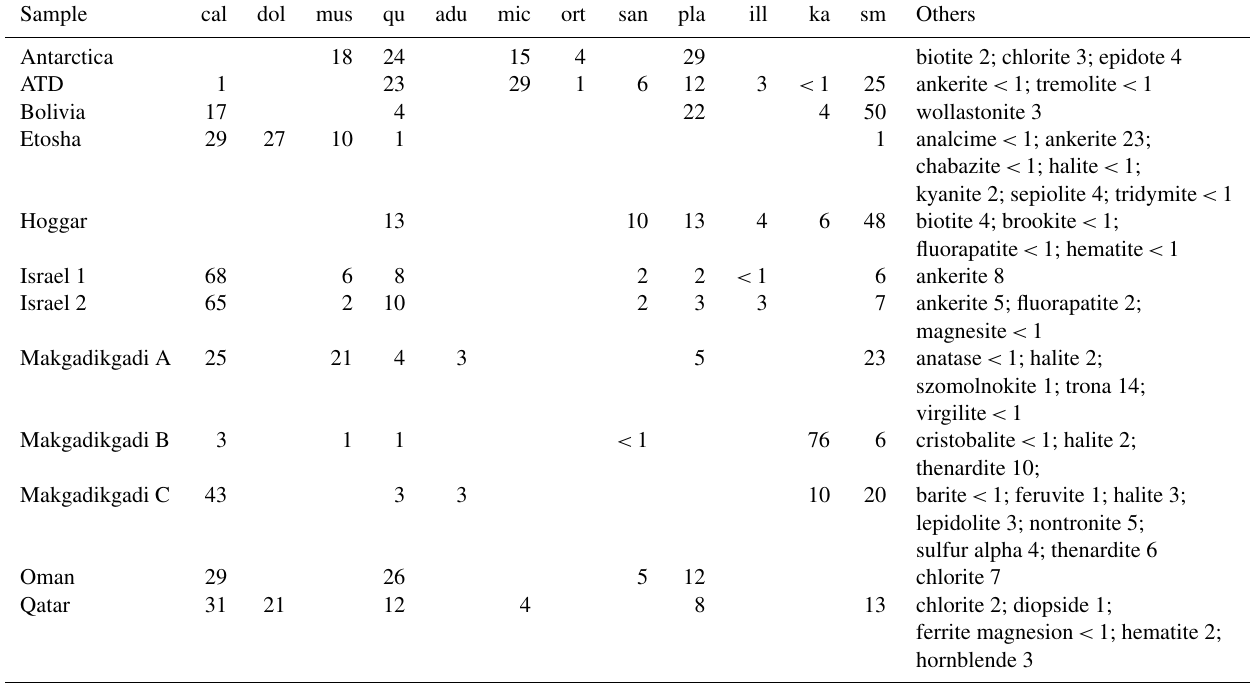
Table 3. Mineralogical composition of natural dust samples in wt% derived from the Rietveld analysis of the X-ray diffraction (XRD) patterns. The abbreviations stand for cal: calcite; dol: dolomite; mus: muscovite; qu: quartz; adu: adularia; mic: microcline; ort: orthoclase;